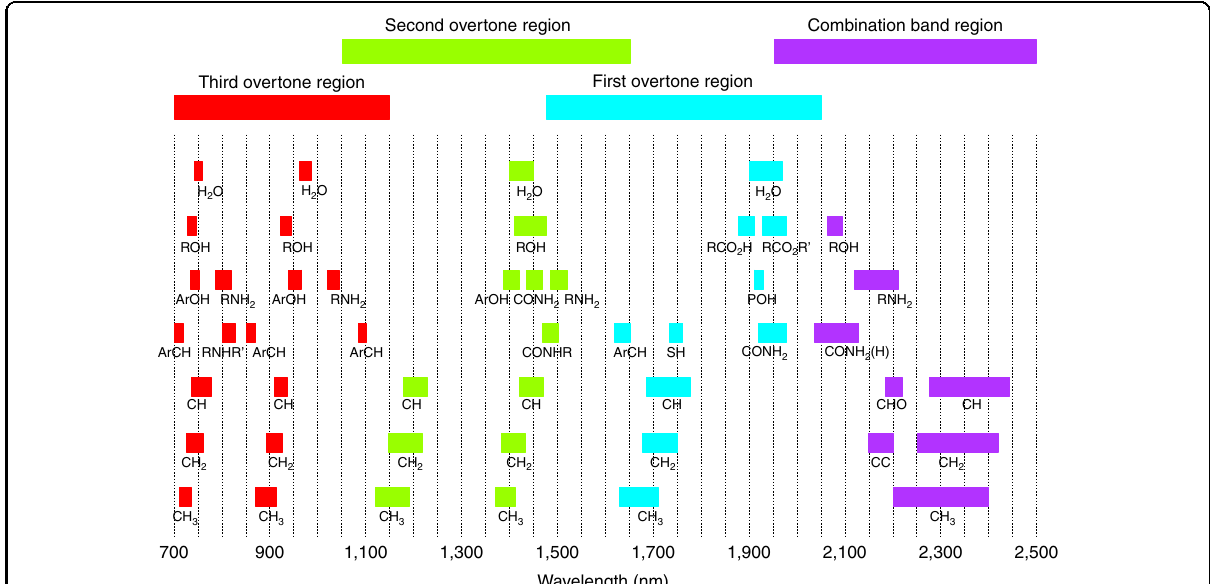
Fig. 3 Approximate positions of the vibrational mode assignments of exemplary functional groups in the NIR band. Reprinted from ref. 35 with permission from